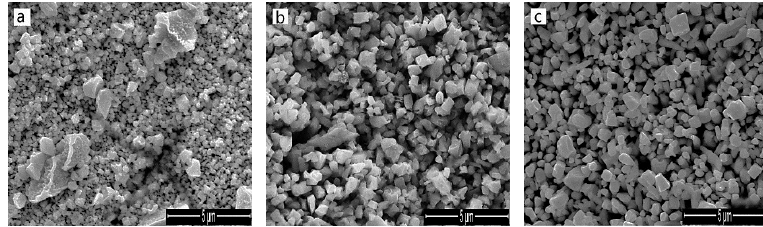
Figure 2. SEM images of IrO X electrodes fabricated at 750 °C ( a ), 800 °C ( b ), and 850 °C ( c ).